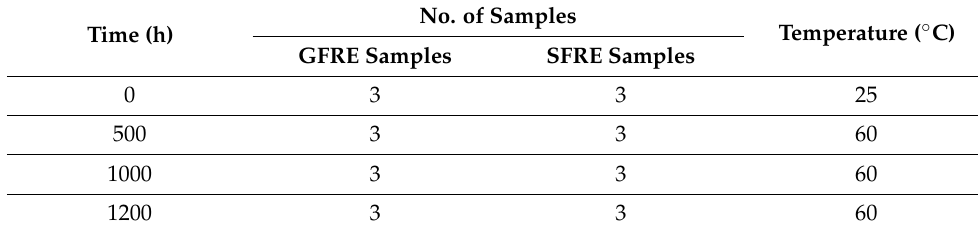
Table 3. Hydrothermal ageing scheme of GFRE and SFRE with respect to time and temperature. No. of Samples Time (h)